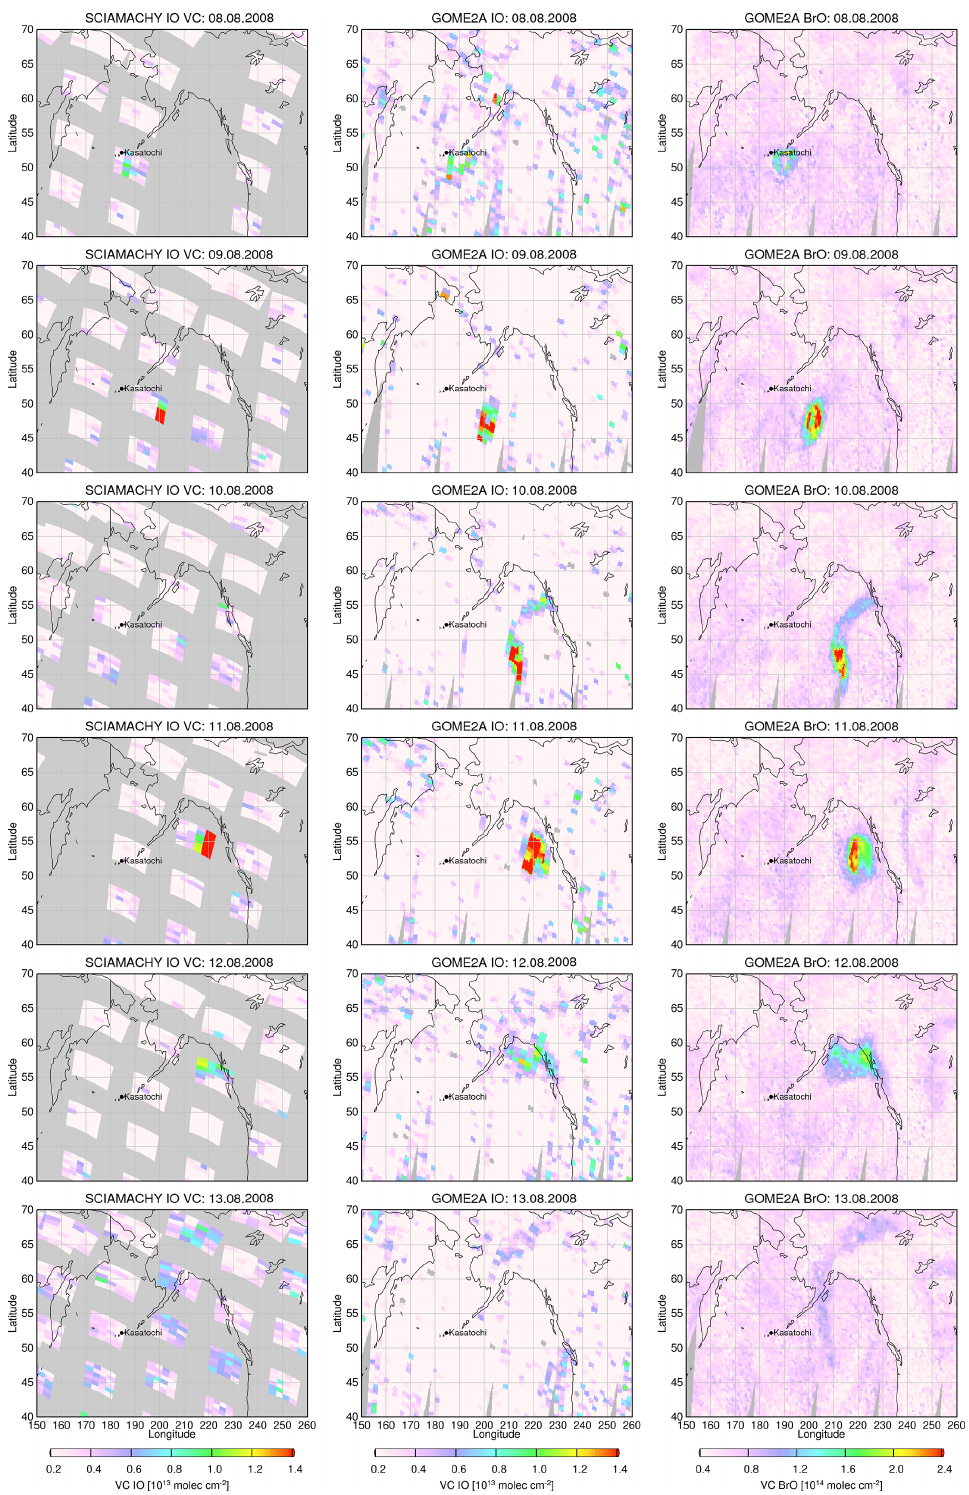
Figure 2. Retrievals of IO from SCIAMACHY (left) and GOME-2A (middle) together with observations of BrO from GOME-2A (right) for 6 days following the eruption of the Kasatochi volcano on 8 August 2008. Regions without data coverage are shaded in